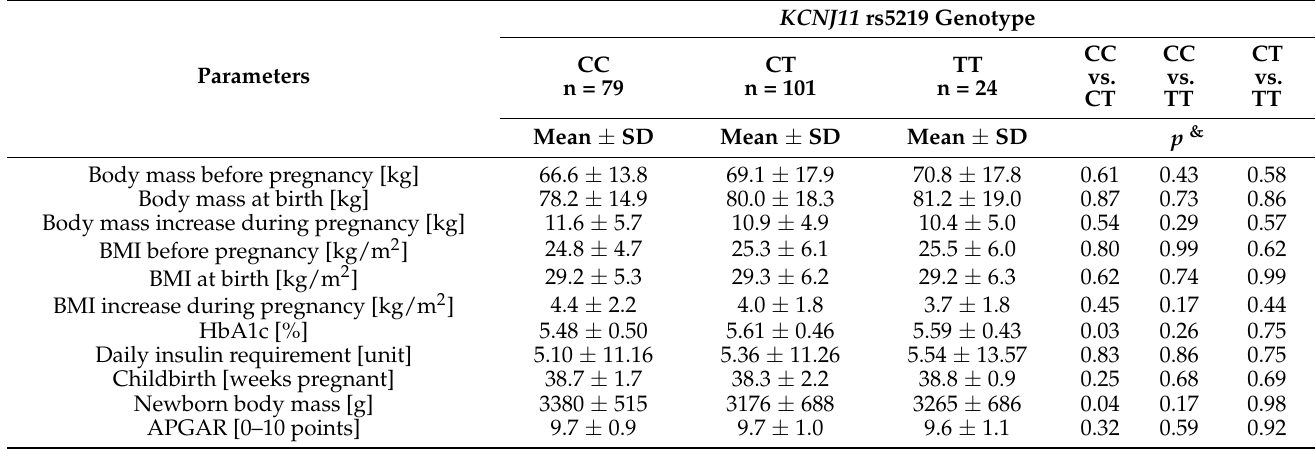
Table 5. Clinical parameters of women with GDM stratified according to KCNJ11 rs5219 genotype.